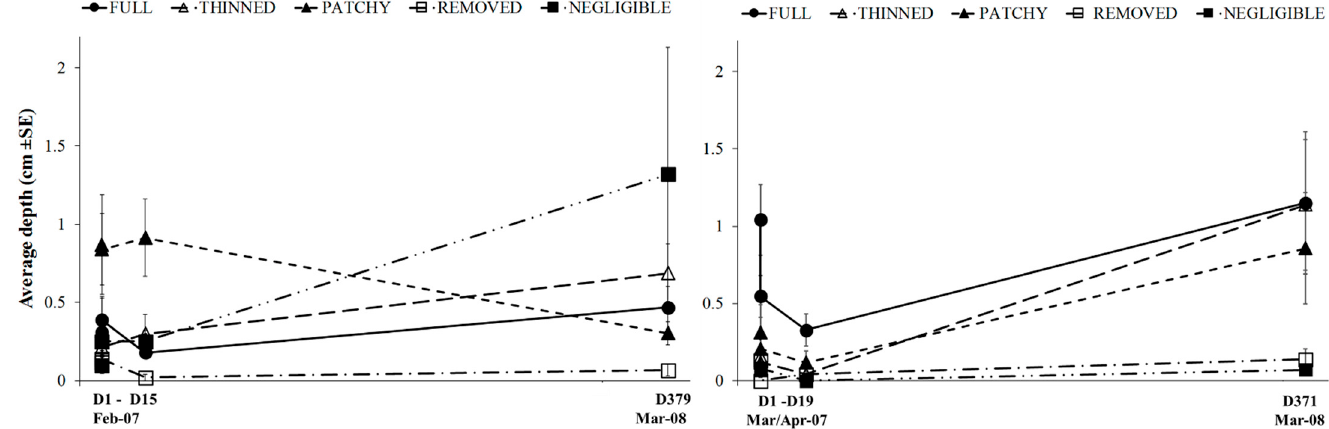
± se) between treatments and over time at 13th Beach (left hand side) and Bridgewater Bay (right hand side). Diversity 2019 , 11 , x FOR PEER REVIEW